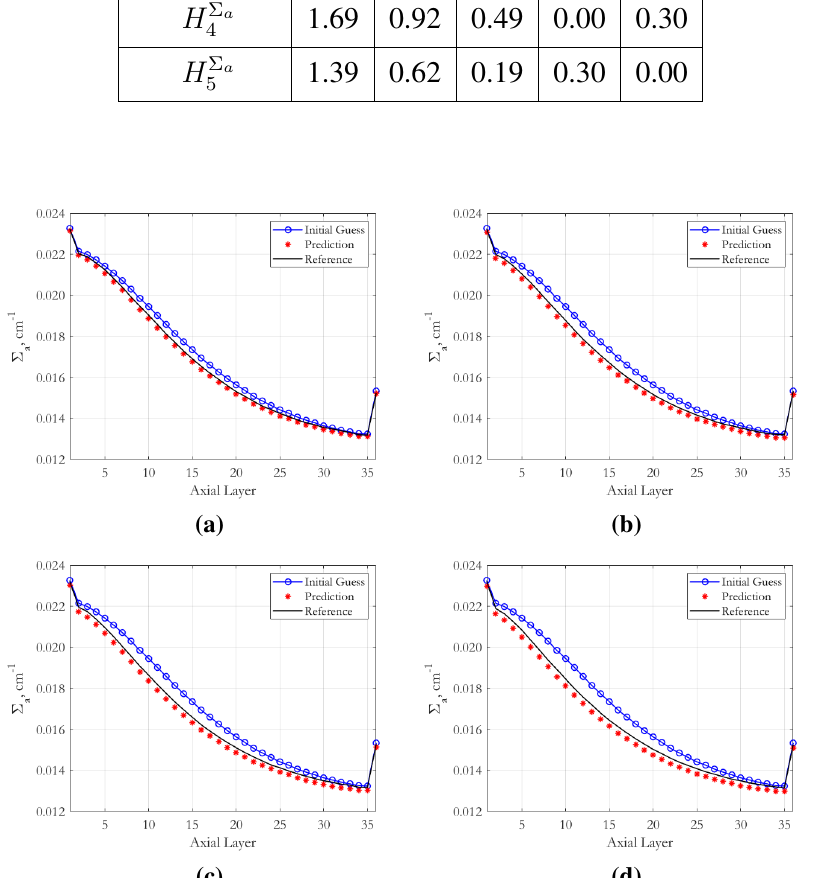
Figure 3: Predictions of the macroscopic absorption cross-sections’ spatial distribution (star markers) compared with the MC-generated reference solution (dashed lines) and the initial guess for: (a) ρ , (b) ρ , (c) ρ , (d) ρ . Transfer function calculated at ρ 2 3 4 5